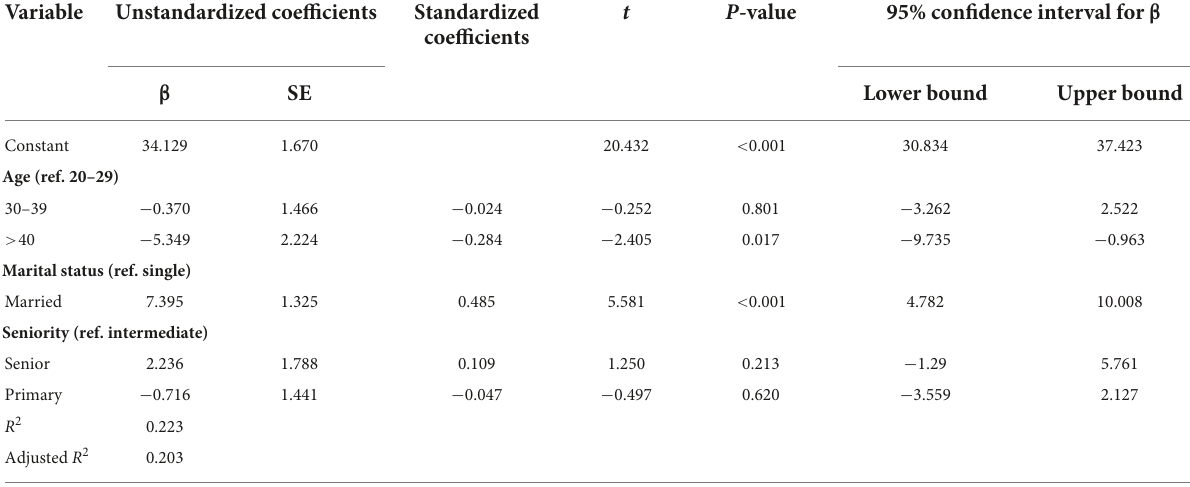
TABLE 4 Regression analysis of the effects of demographic factors on social